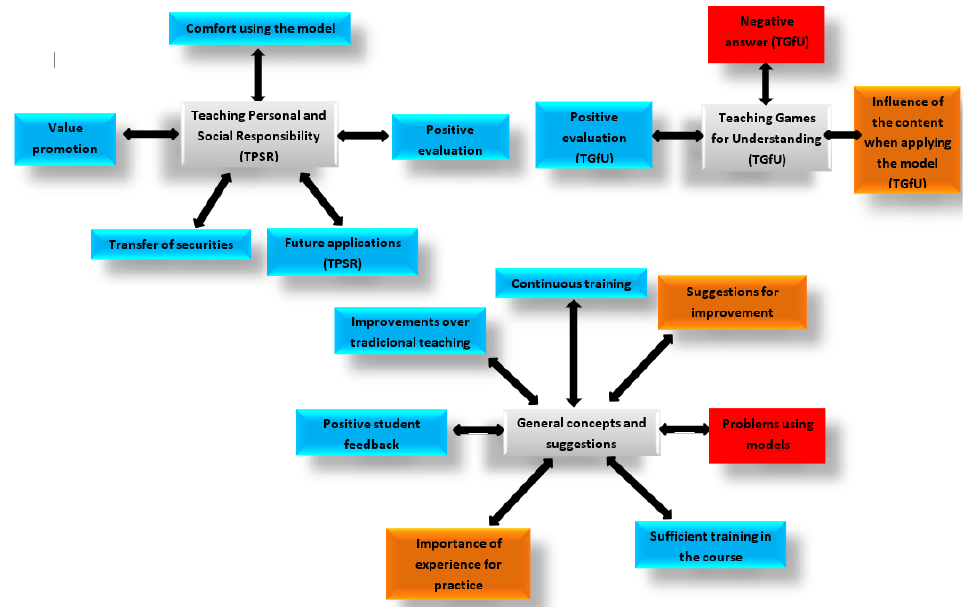
Figure 1. Teacher evaluations on the implementation of pedagogical models in physical education.